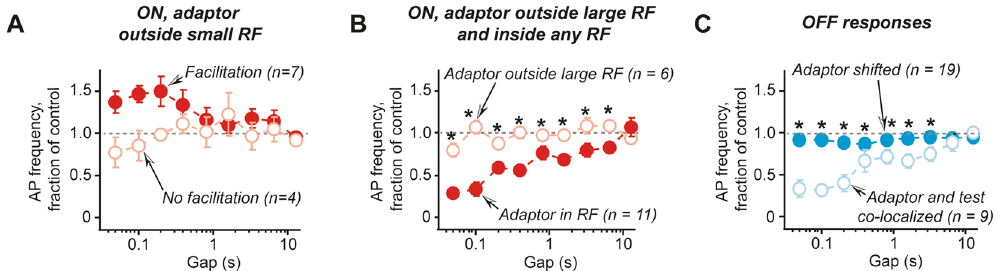
Figure 6. The summary for non-locally induced adaption. ( A ) The average response time-course for all units, which showed significant facilitation for at least one time point when the adaptor was placed close to the small RF (filled circles). For comparison, also units with no facilitation under similar stimulation conditions are shown. ( B ) No facilitation was observed for units with large RF ( > 20°). The averaged data for all such units with adaptor placed inside RF (filled circles) and outside RF (open circles) are shown. In both cases the adaptor and the test stimuli were > 10° apart. ( C ). No adaptation was observed for all OFF responses when the adaptor and the test stimuli were > 10° apart (filled circles). For comparison, the average of all OFF responses when the adaptor and the test stimuli were co-localized is also shown (open circles). In ( B , C ) asterisks indicate gap durations for which statistically significant differences between two conditions was found (p <